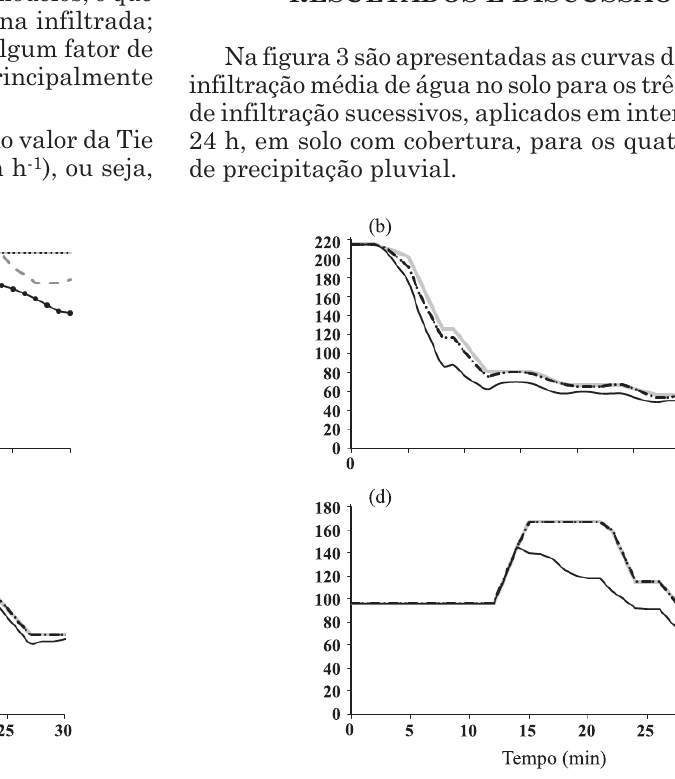
figura 3. taxa de infiltração (ti) para os três ensaios experimentais realizados consecutivamente em solo com cobertura, espaçados 24 h entre si, com perfil de precipitação pluvial constante (a), exponencial decrescente (b), duplo exponencial adiantado (c) e duplo exponencial atrasado